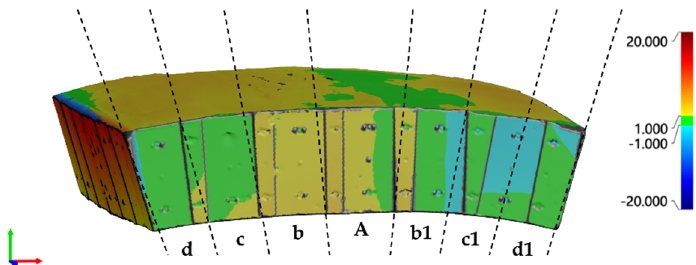
Figure 8. Side error of FCP based on design form. (Unit: